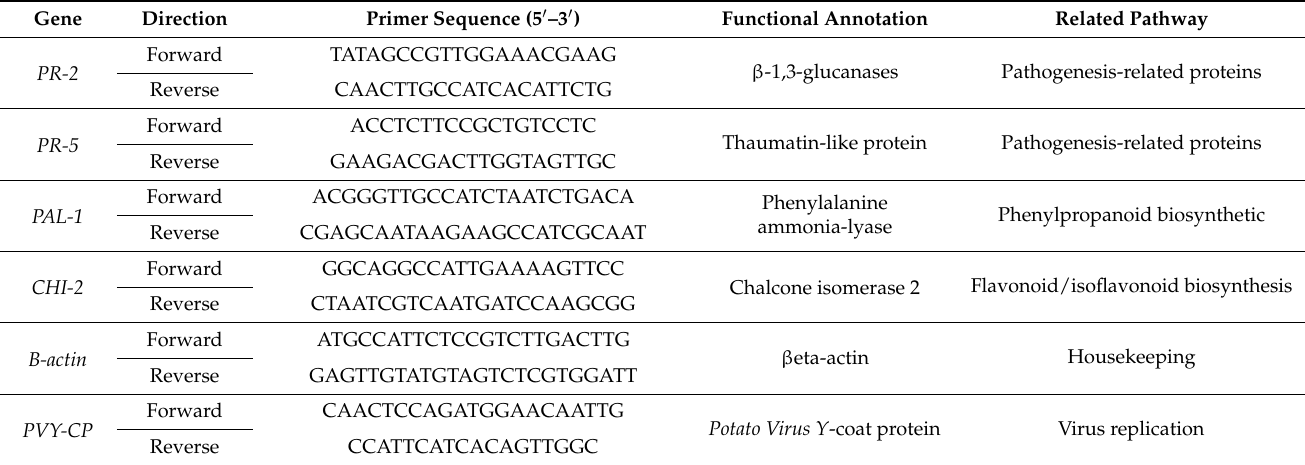
Table 1. Nucleotide sequences of qPCR primers used for defense response in this